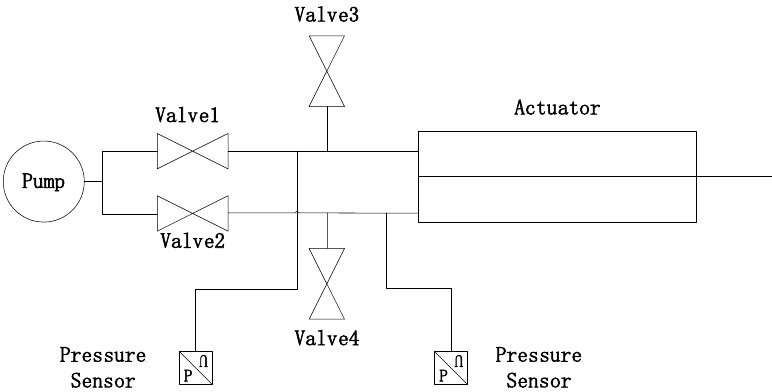
Figure 3. The schematic of control system for the bi-directionally pneumatic actuator. The air valves shown in the figure are controlled by a microcontroller unit (MCU).